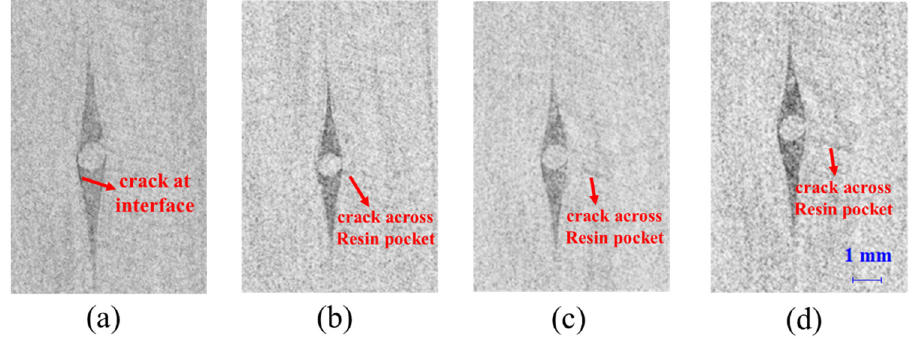
Figure 5: Microscopic morphology at di ff erent locations through the second direction of Z - pinned composites after moisture coupled with fl exural load for 7 days. ( a ) Shows crack at interface; ( b, c and d ) show crack across resin